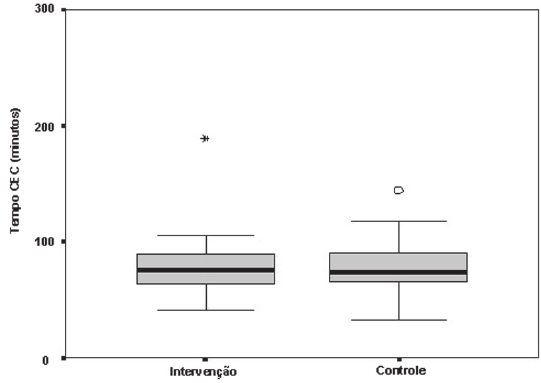
Fig. 1 - Tempo de circulação extracorpórea (CEC) O valor médio da pressão inspiratória máxima (PI máxima)